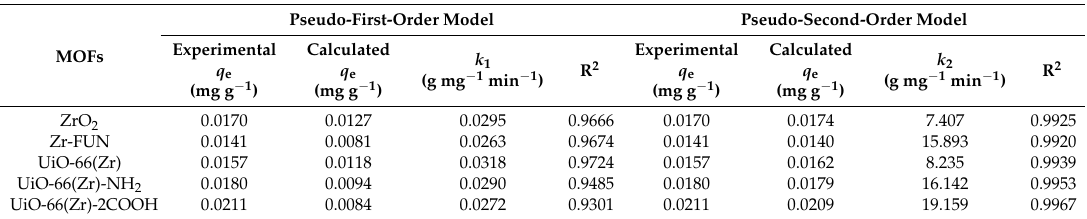
Table 2. Adsorption kinetic parameters for the adsorption of verapamil on various Zr-based MOFs